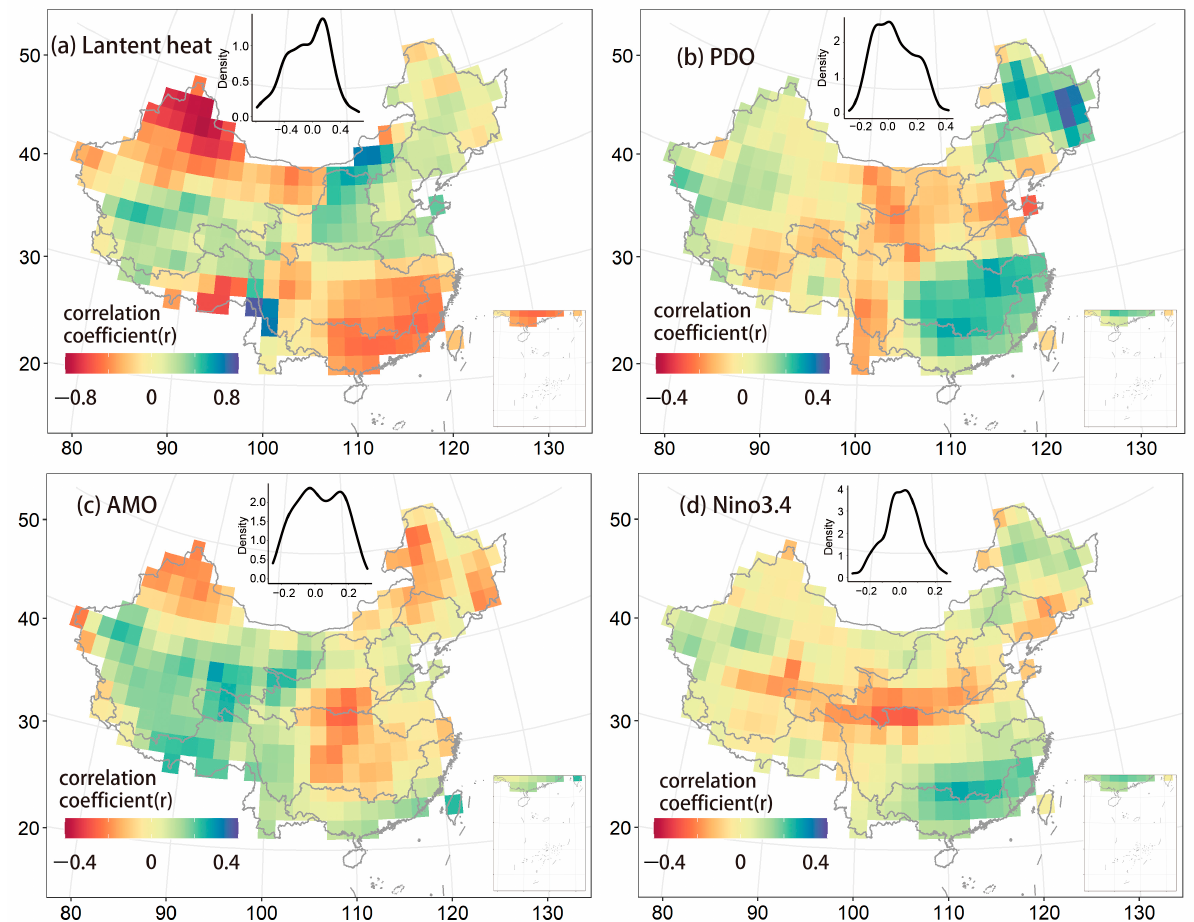
Figure 7. Spatial distribution of SSMI response to LHF, PDO, AMO and Nino3.4